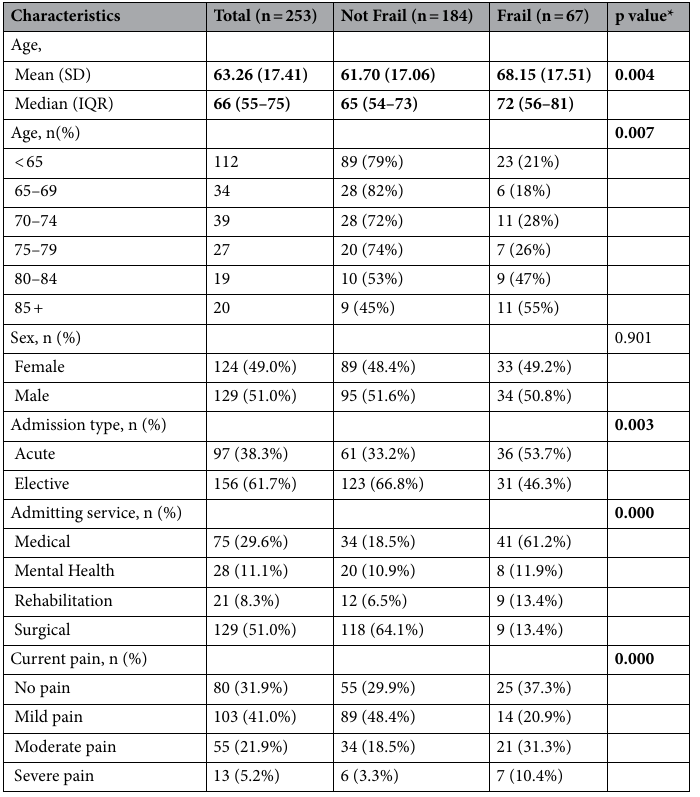
Table 2. Patient characteristics by frailty type. *Chi-square tests. Bold means statically significant.